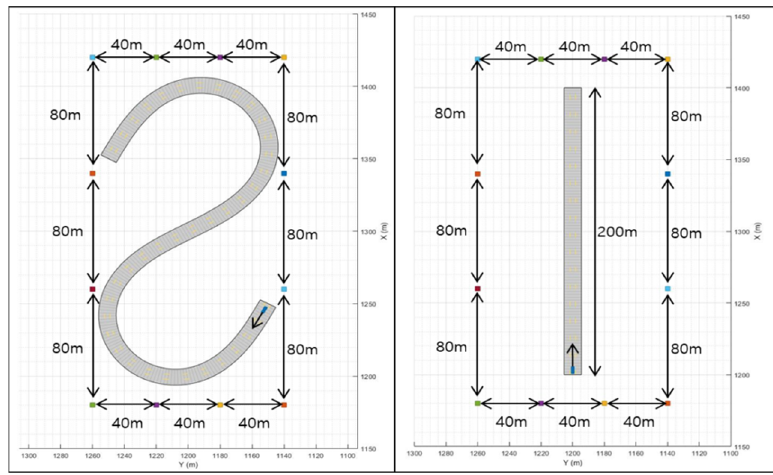
Figure 3. Simulation model.